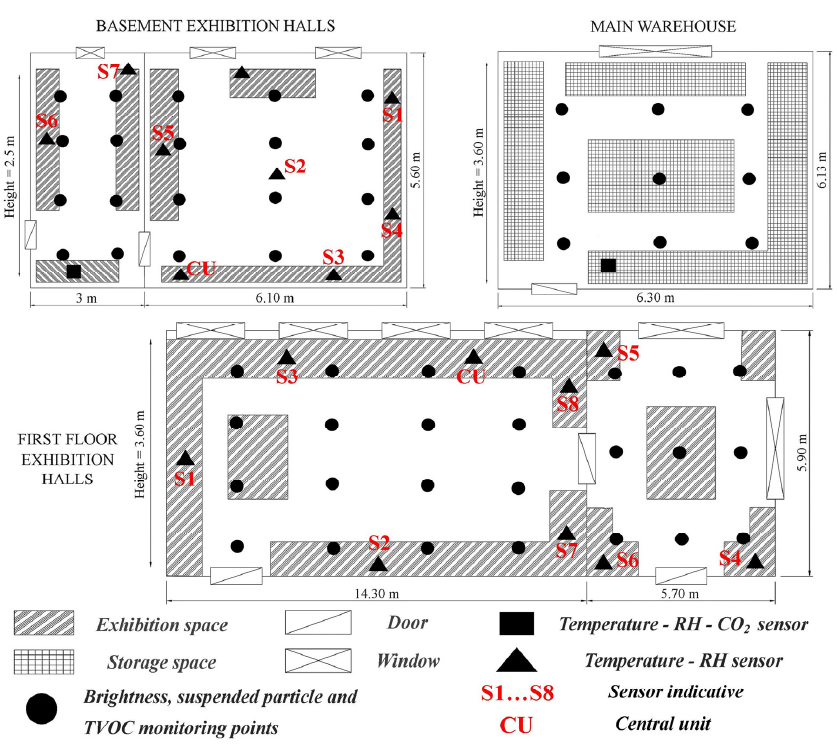
Figure 3. Distribution of sensors in the studied museum halls .